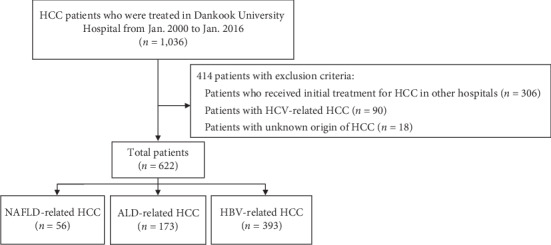
Schematic diagram of the study design and patients enrollment. HCC: hepatocellular carcinoma; ALD: alcoholic liver disease; HBV: hepatitis B virus; NAFLD: nonalcoholic fatty liver disease; HCV: hepatitis C virus.